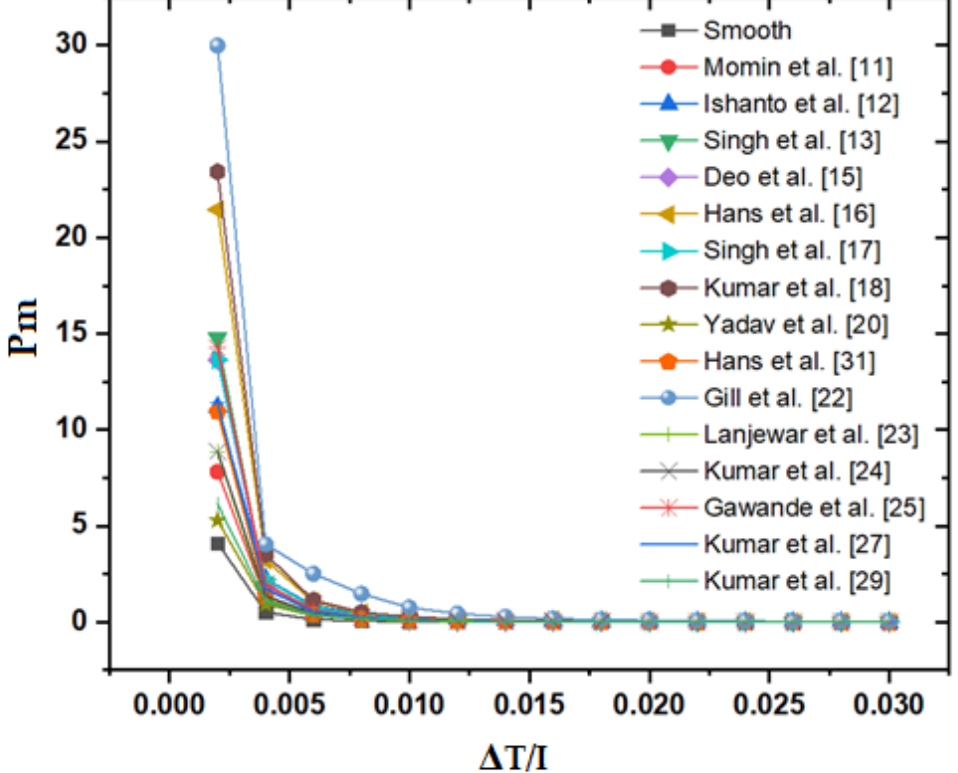
Figure 6. Pumping power requirement of the roughened duct with respect to Δ T/I.